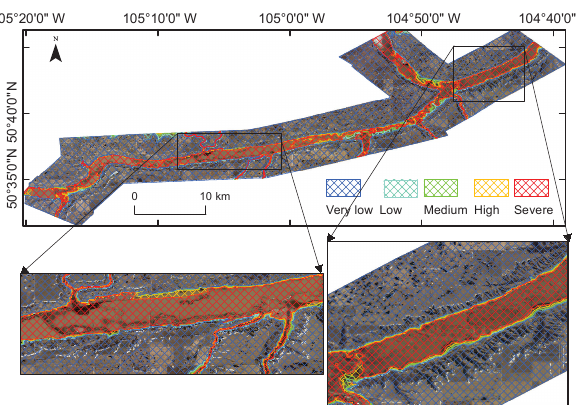
Figure 5. Comparison of hazard map with aerial image of a single flood event on the Qu’Appelle River, Saskatchewan